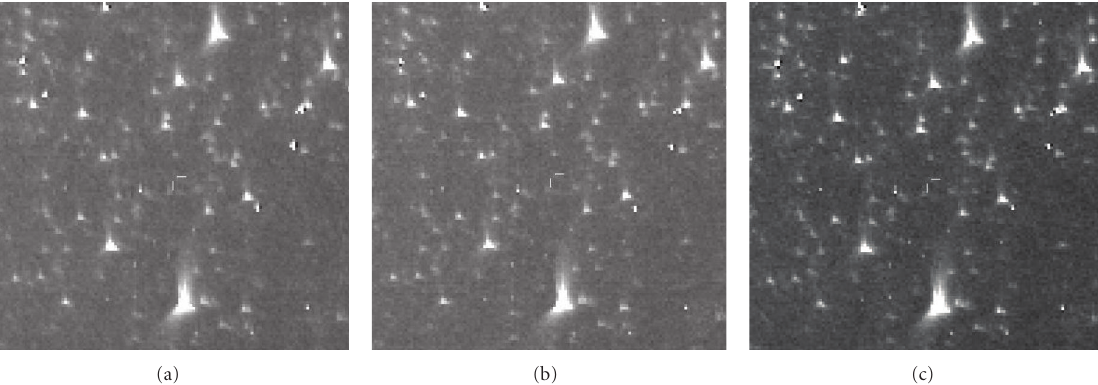
Figure 14: Coadded images taken 30 seconds before (a), during (b), and 30 seconds after (c) GRB081102. Each frame is a coadd of 12 images (six images from each camera)—60 seconds exposure for each frame. FOV 3 ◦ × 3 ◦ on the frame edge. So strange stars shape is connected with o ff -axis aberrations. Animation is available here: http://observ.pereplet.ru/images/GRB081102/grb film.html.